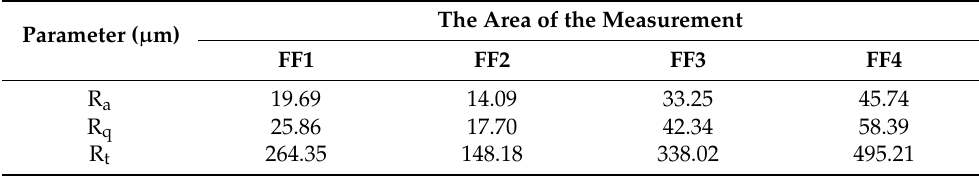
Figure 16. Example of surface roughness measurements area: ( a ) BD4 on the back surface; ( b ) FF3 on the front surface. Table 7. The results of surface roughness measurements on the front surface.